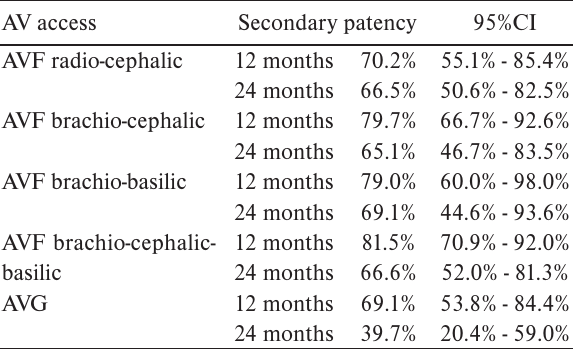
Table 3. Secondary patency of all AV